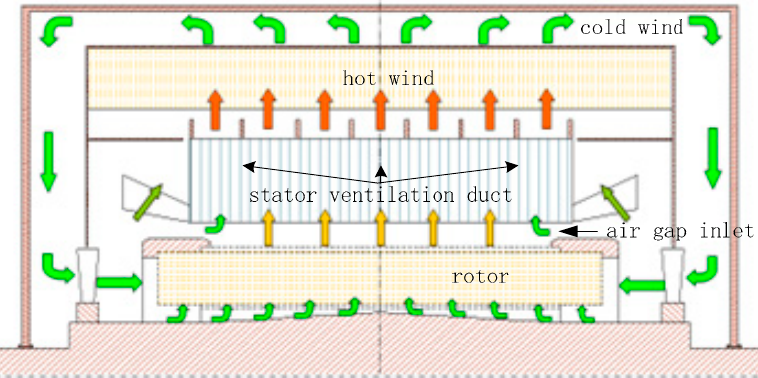
Figure 1. Single-channel ventilation air-cooled turbo-generator ventilation system.